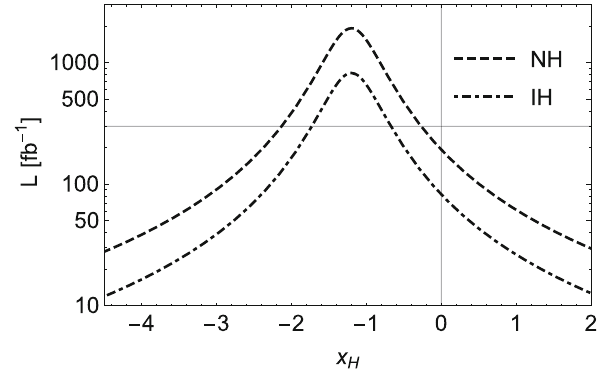
Fig. 8 The luminosity required to obtain 25 signal events of the Z (cid:2) bosonasafunctionof x H forfixedvaluesof m Z (cid:2) = 3TeVand m N 1 , 2 , 3 = m Z (cid:2) / 4.Thedashed(dot-dashed)linescorrespondtoNH(IH)caseswith (cid:6) 2 ( N i → μ ± μ ± W ∓ W ∓ ) = 0 . 148 (0 . 0634). The vertical i m N m i = 1 BR solid line marks the B − L limit ( x H = 0). The solid horizontal line correspondstoaluminosityvalueof300fb − 1 requiredforthediscovery of RHNs at the future LHC with a dimuon and a diboson final states